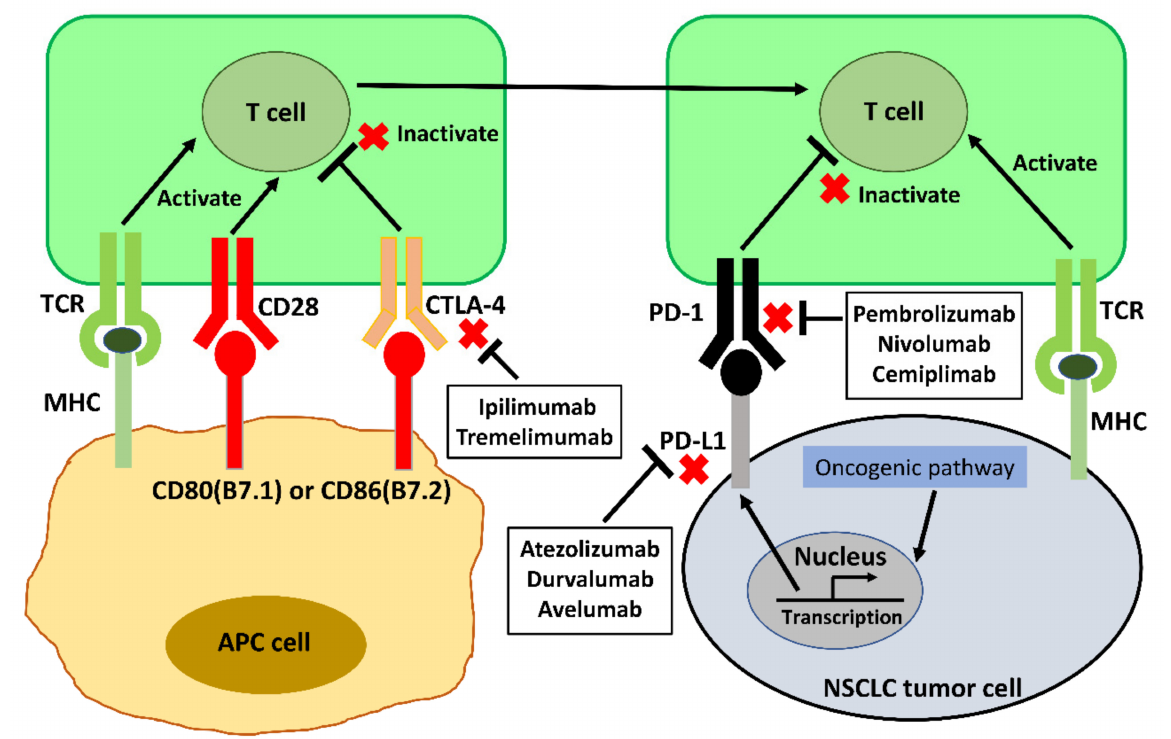
Figure 1. Mechanism of anti-PD-1/PD-L1 and anti-CTLA-4 ICIs in anti-cancer therapy for NSCLC. Abbreviations: APC, antigen-presenting cell; TCR, T-cell receptor; MHC, major histocompatibility complex; PD-L1, programmed Death-Ligand 1; PD-1, programmed Cell Death Protein-1 (PD-1); CTLA-4, cytotoxic T-lymphocyte-associated protein